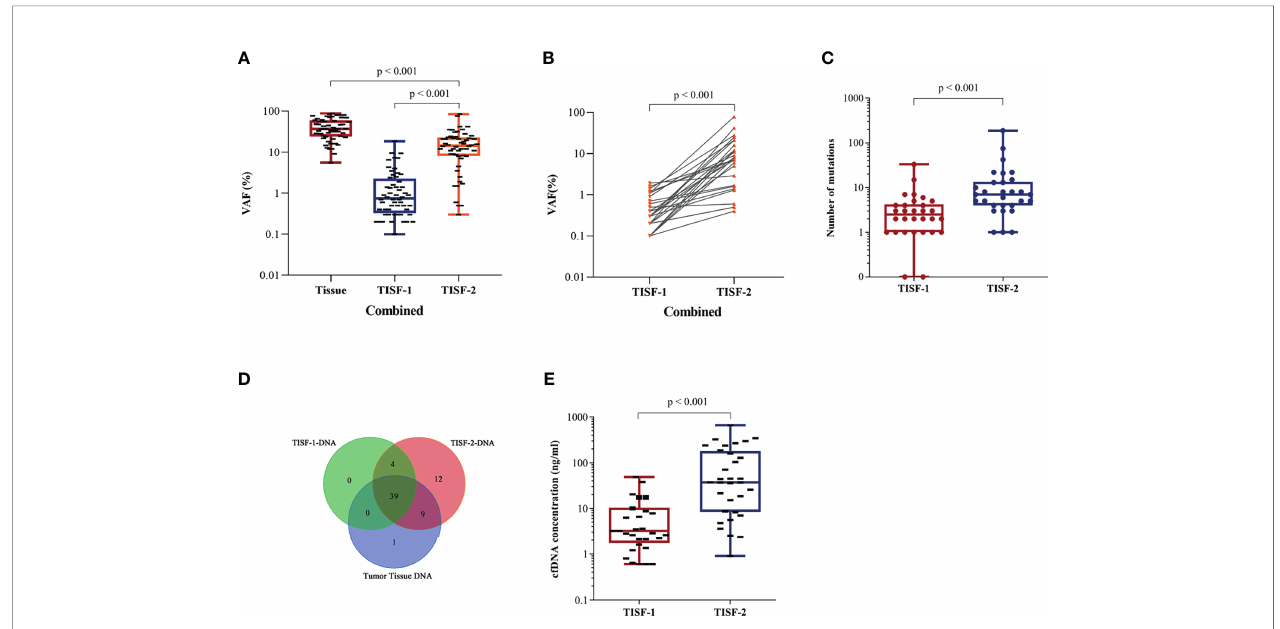
FIGURE 3 | Longitudinal analysis of tumor DNA from TISF in different stages. (A) VAF changes in primary and recurrent tumor trunk mutations ( p < 0.0001). (B) VAF of TISF shared mutation is elevated when tumor progression ( p < 0.0001). (C) Elevated mutation load at tumor progression ( p < 0.0001). (D) Twelve novel genotypes were detected in TISF-2 at tumor recurrence. (E) The concentration of TISF-cfDNA increased during tumor progression ( p <